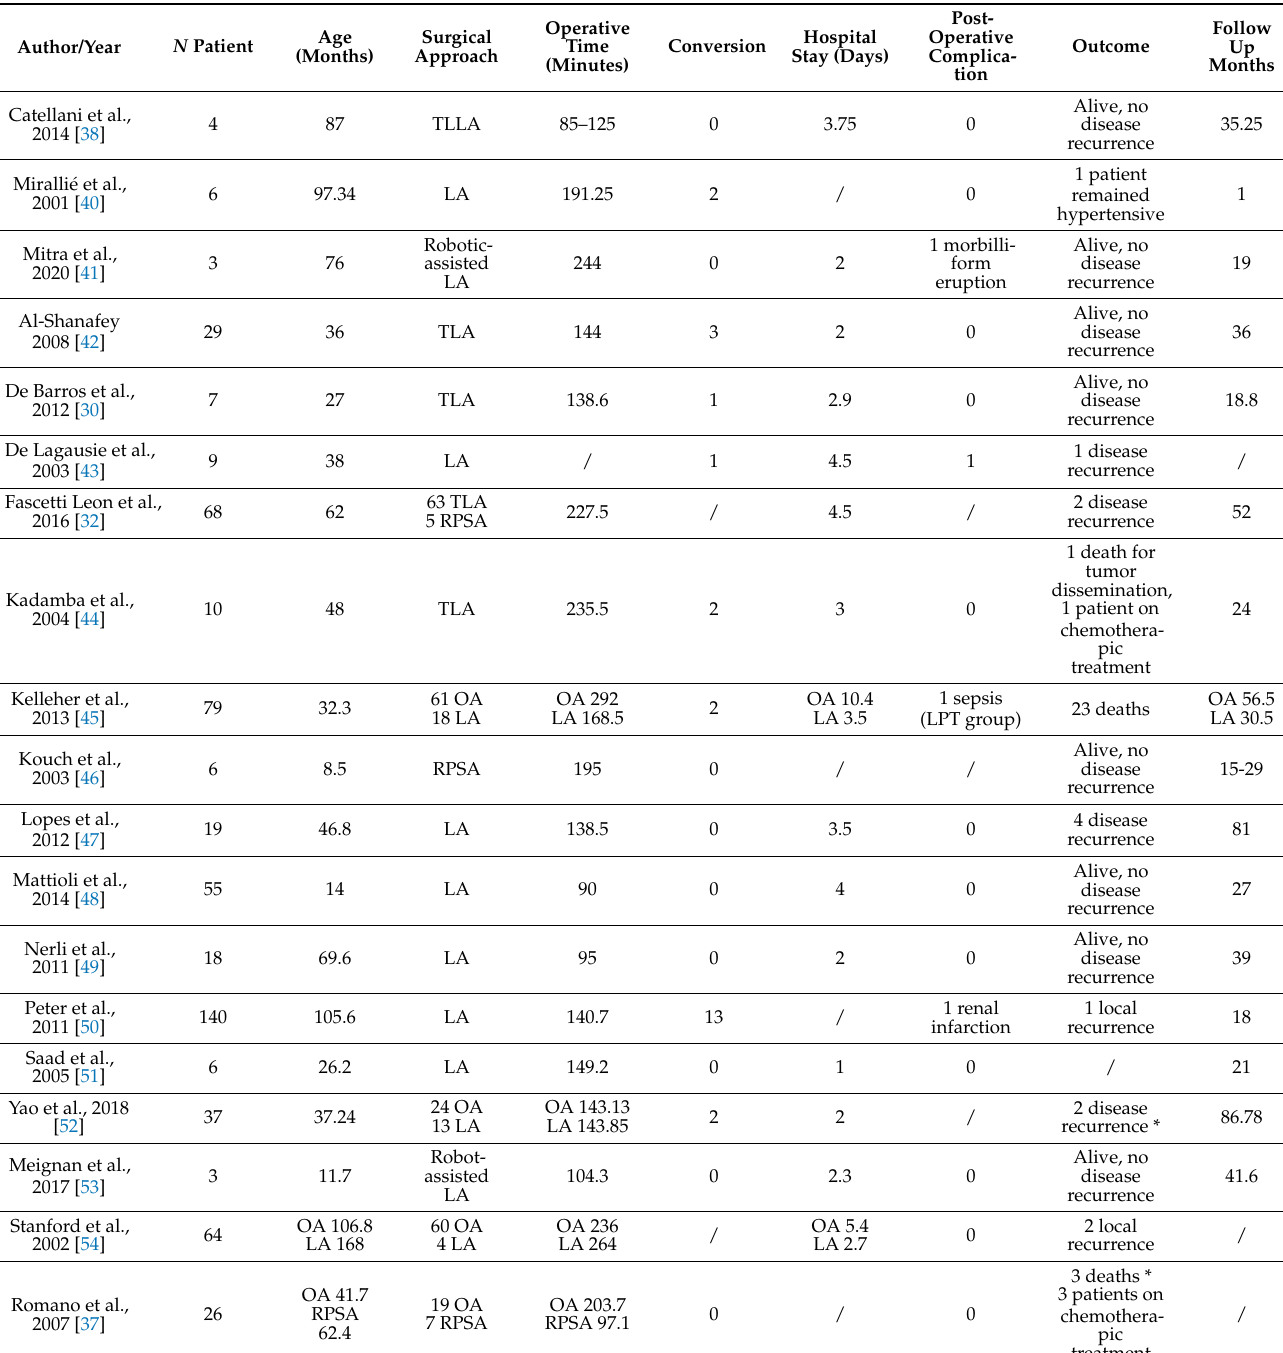
Table 2. Comparison of surgical techniques for adrenalectomy. (TLLA = Transperitoneal Lateral Laparoscopic Adrenalec- tomy; LA = Laparoscopic Adrenalectomy; TLA = Transperitoneal Laparoscopic Adrenalectomy; RPSA = Retroperineoscopic Adrenalectomy; OA = Open Adrenalectomy; * = Open Adrenalectomy